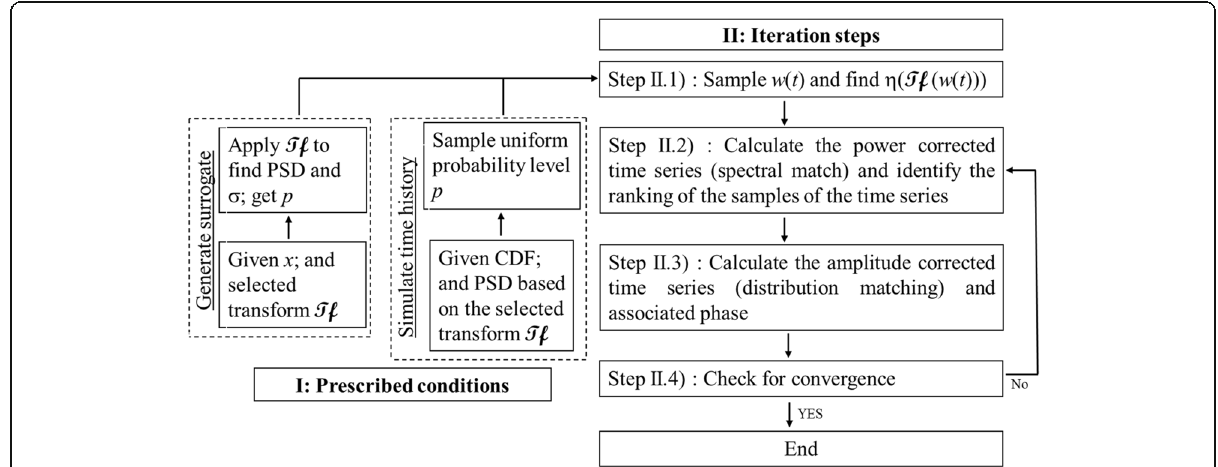
Fig. 1 Iterative power and amplitude correction algorithm to simulate nonstatinary and non-Gaussian processes (Tf denotes the selected transform in this